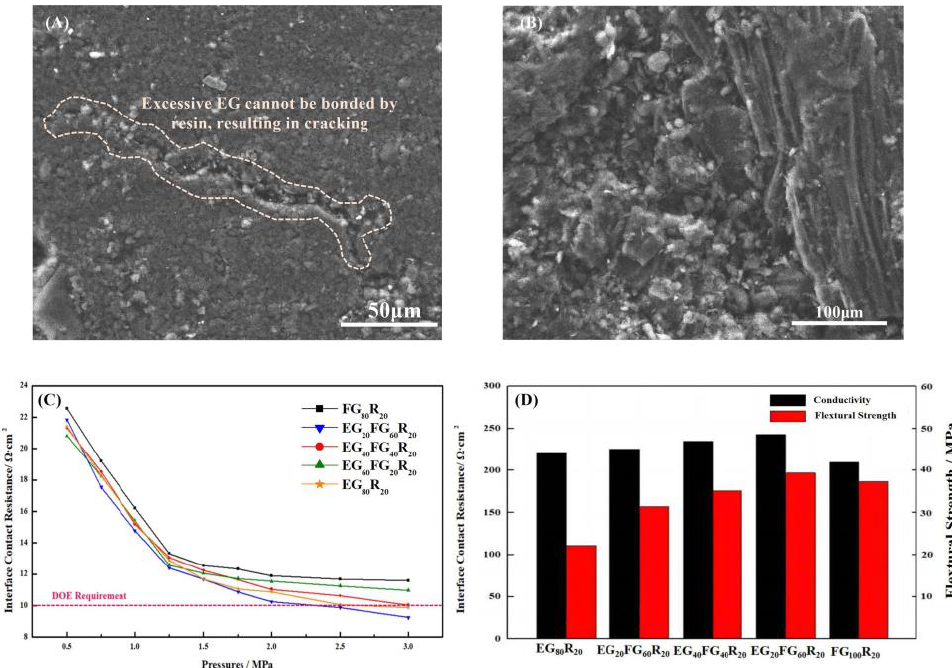
Figure 6. ( A , B ) SEM images of the composite BPs prepared by EG and FG; ( C ) effect of different ratios of EG and FG on ICR; ( D ) effect of different ratios of EG and FG on the performance of